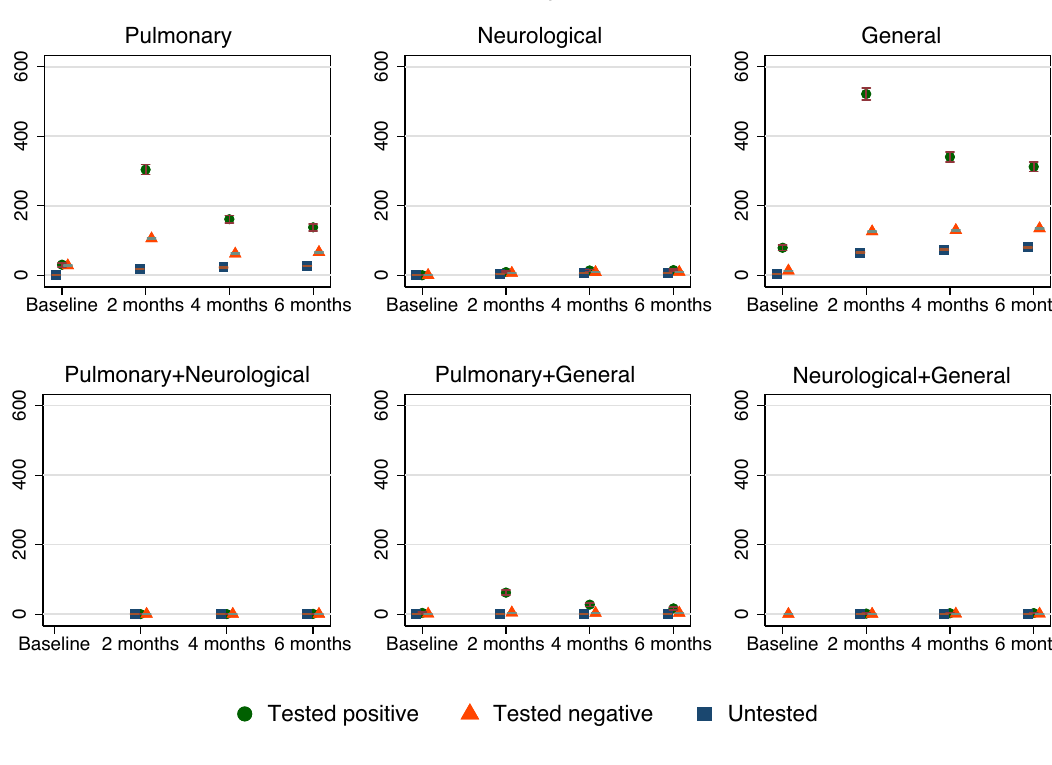
Figure 1. The adjusted prevalence in percent and 95% confidence interval for different long COVID complaints at baseline, 2, 4 and 6 months followup for persons testing negative and positive for SARS-CoV-2. Missing circles, triangles or squares indicate no observation for the group in question. The prevalence of pulmonary + neurological + general complaints could not be plotted due to very few Testing positive for SARS-CoV-2 Testing negative for SARS-CoV-2 Untested for SARS-CoV-2 N = 75 979 N = 1 167 582 N = 1 084 578